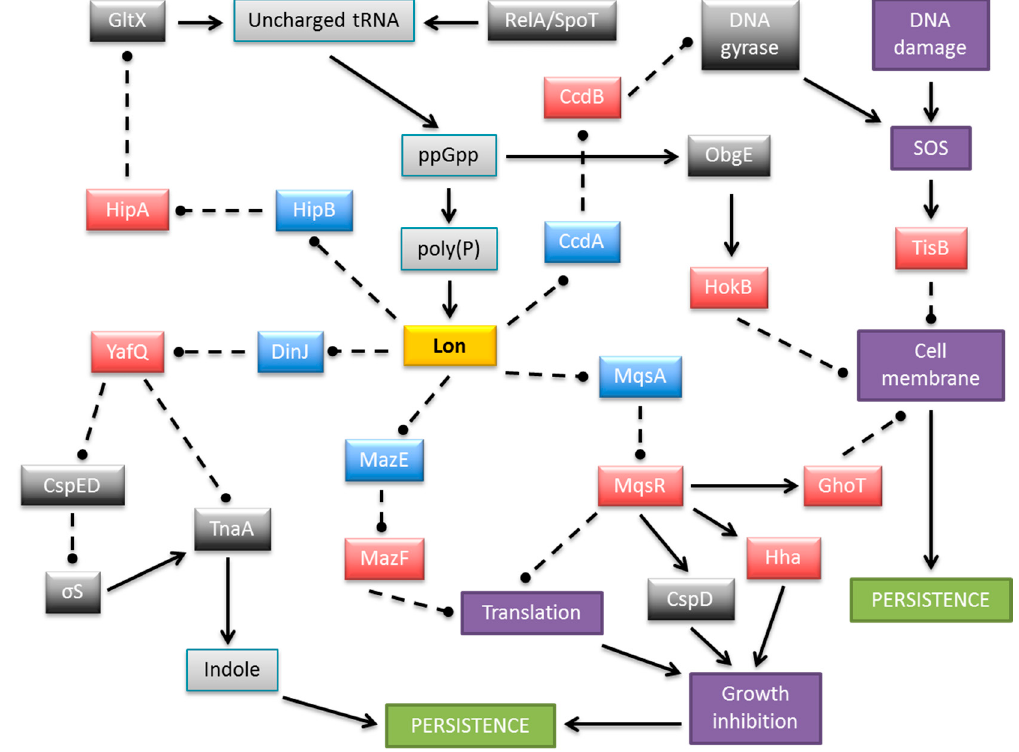
Figure 4. Schematic representation of a complex and multilayered protein network engaged in persistence formation in E. coli via TA complexes. The central part illustrates Lon protease as an example of antitoxin degrading proteases, which also include ClpXP and ClpAP. MazEF is shown as an exemplar type II module in which the toxin is an endoribonuclease. Only the relevant, most well-described interactions are displayed. Colored boxes denote toxins (red), antitoxins (blue), Lon protease (yellow), other proteins (dark grey), small molecules (light grey), and cellular processes and structures (purple). Arrows, stimulation; broken lines ending in balls, inhibition.